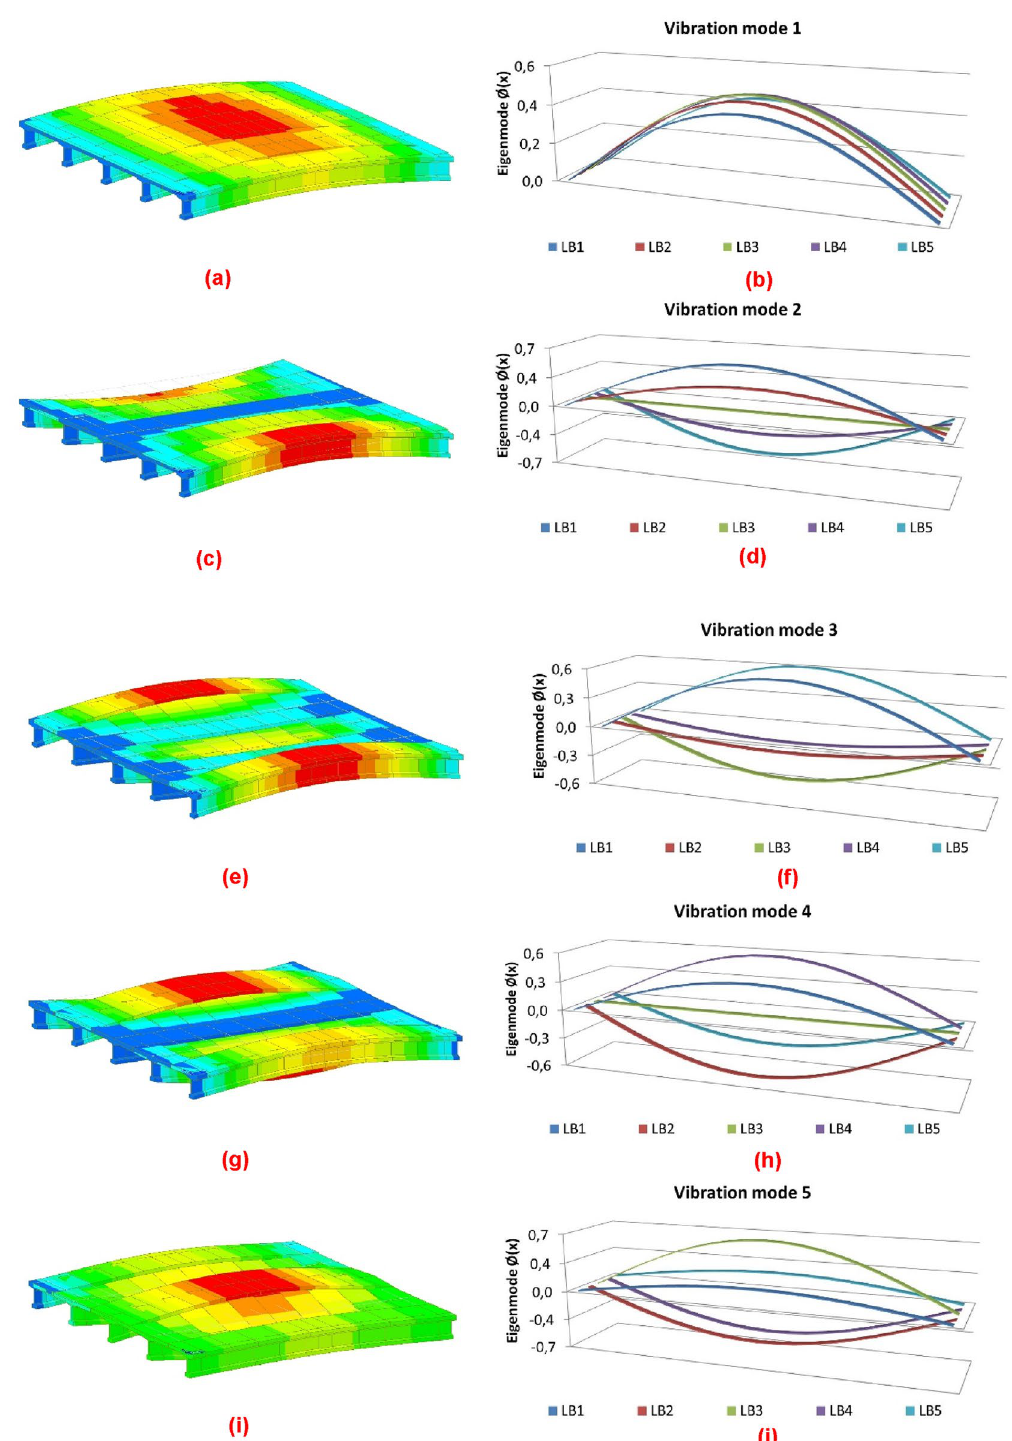
Figure 6. Results of the modal analysis of a five-girder deck: ( a ) mode 1 traditional methods; ( b ) mode 1 proposed method; ( c ) mode 2 traditional methods; ( d ) mode 2 proposed method; ( e ) mode 3 traditional methods; ( f ) mode 3 proposed method; ( g ) mode 4 traditional methods; ( h ) mode 4 proposed method; ( i ) mode 5 traditional methods; ( j ) mode 5 proposed